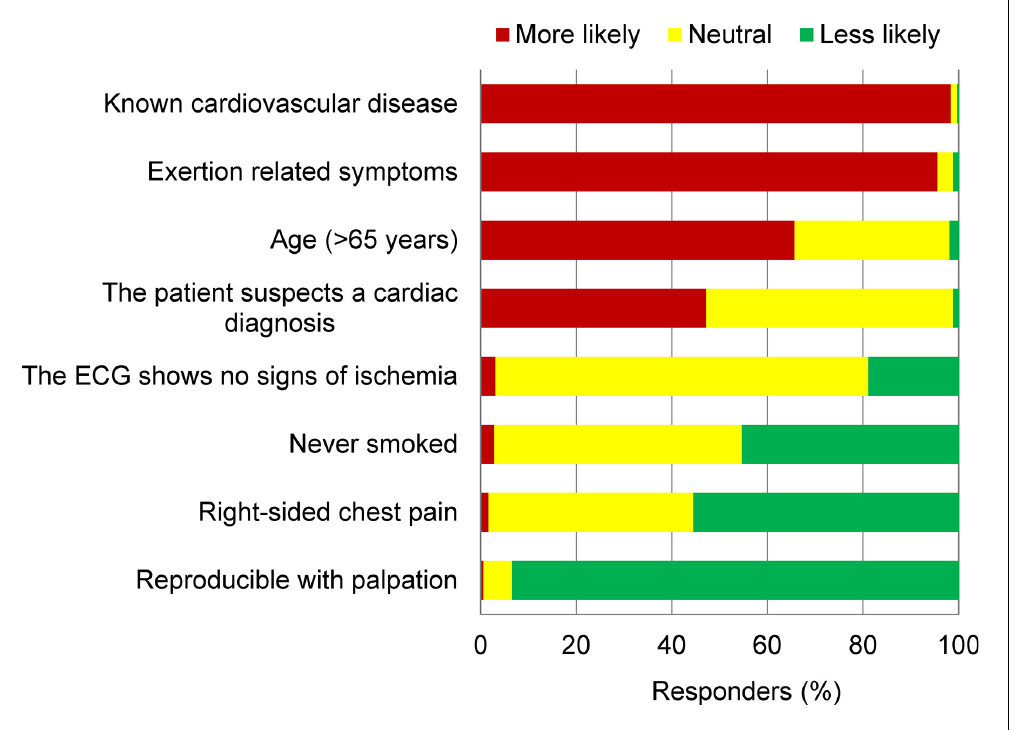
Figure 3. Characteristics that influenced the GP’s likelihood for referral. ECG = electrocardiogram.